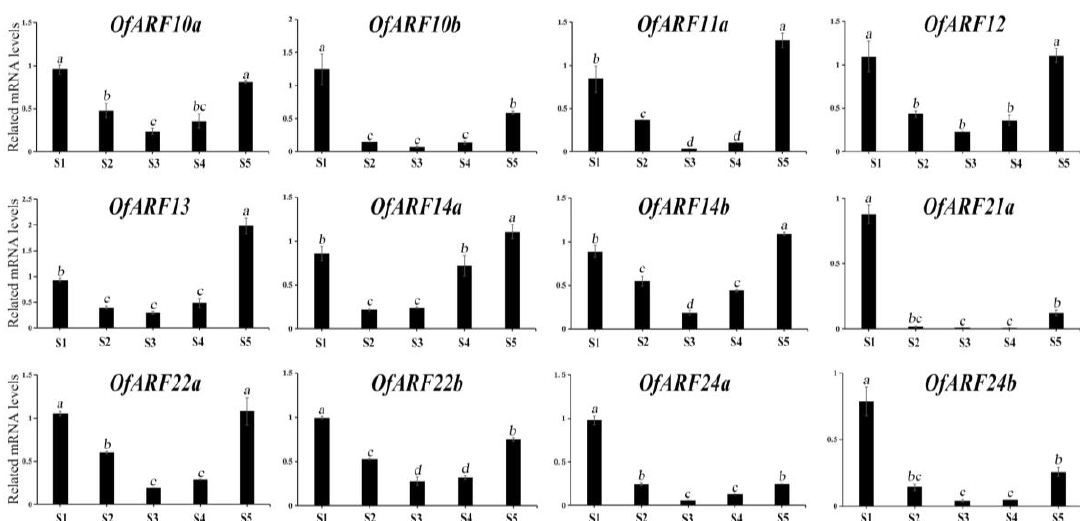
Figure 9. Expression profiles of 12 Osmanthus fragrans auxin response factor genes ( OfARF s) by qPCR. The flower development process in cultivar Rixianggui was marked by stages S1 (linggeng stage), S2 (bud eye stage), S3 (initial flowering stage), S4 (full flowering stage), and S5 (late flowering stage). Changes in the expression levels during different flower developmental stages depicted above are relative to RNA accumulation levels. The error bars represent the standard error from three biological replications. Significant differences detected with Duncan’s multiple range test at p < 0.05 are indicated by different lowercase letters above the error bars.